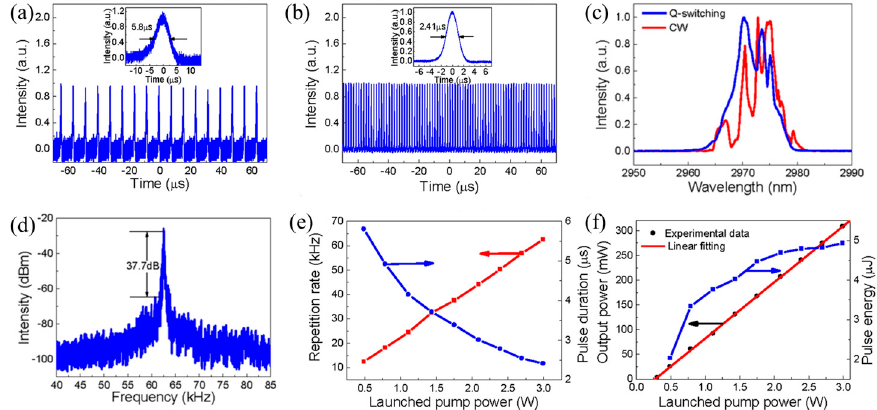
Figure 4. ( a ) Pulse series and monopulse waveform (inset) are 489.3 mW and ( b ) 2.99 W, respectively, at the power of the transmitting pump. ( c ) The measured spectrum of the pulse. ( d ) The RF spectrum of the pulse. ( e ) Change curve of launched pump power with repetition rate. ( f ) Launched pump power change curve with output power [205]. Copyright 2016 Nature Publishing